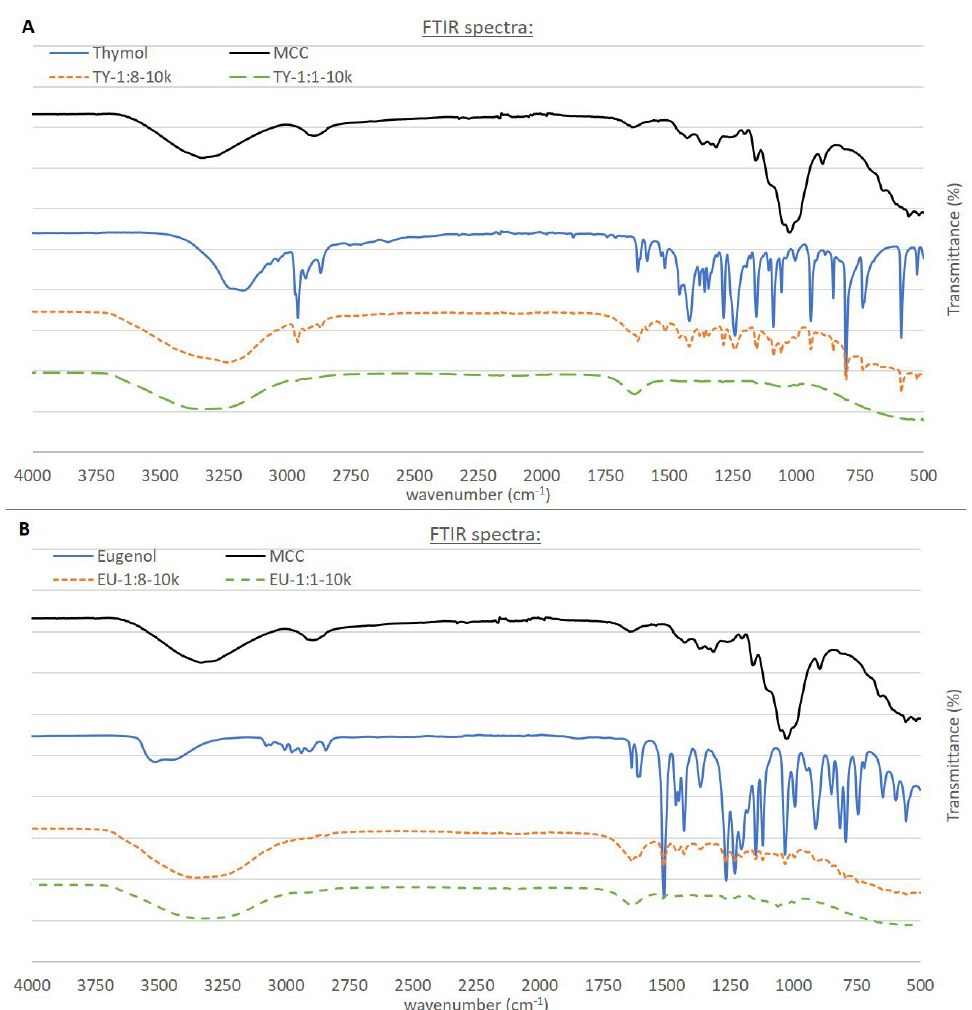
Figure 6. FTIR spectra of MCC and ( A ) neat TY, TY-1:8-10k and TY-1:1-10k and ( B ) neat EU, EU-1:8- 10k and